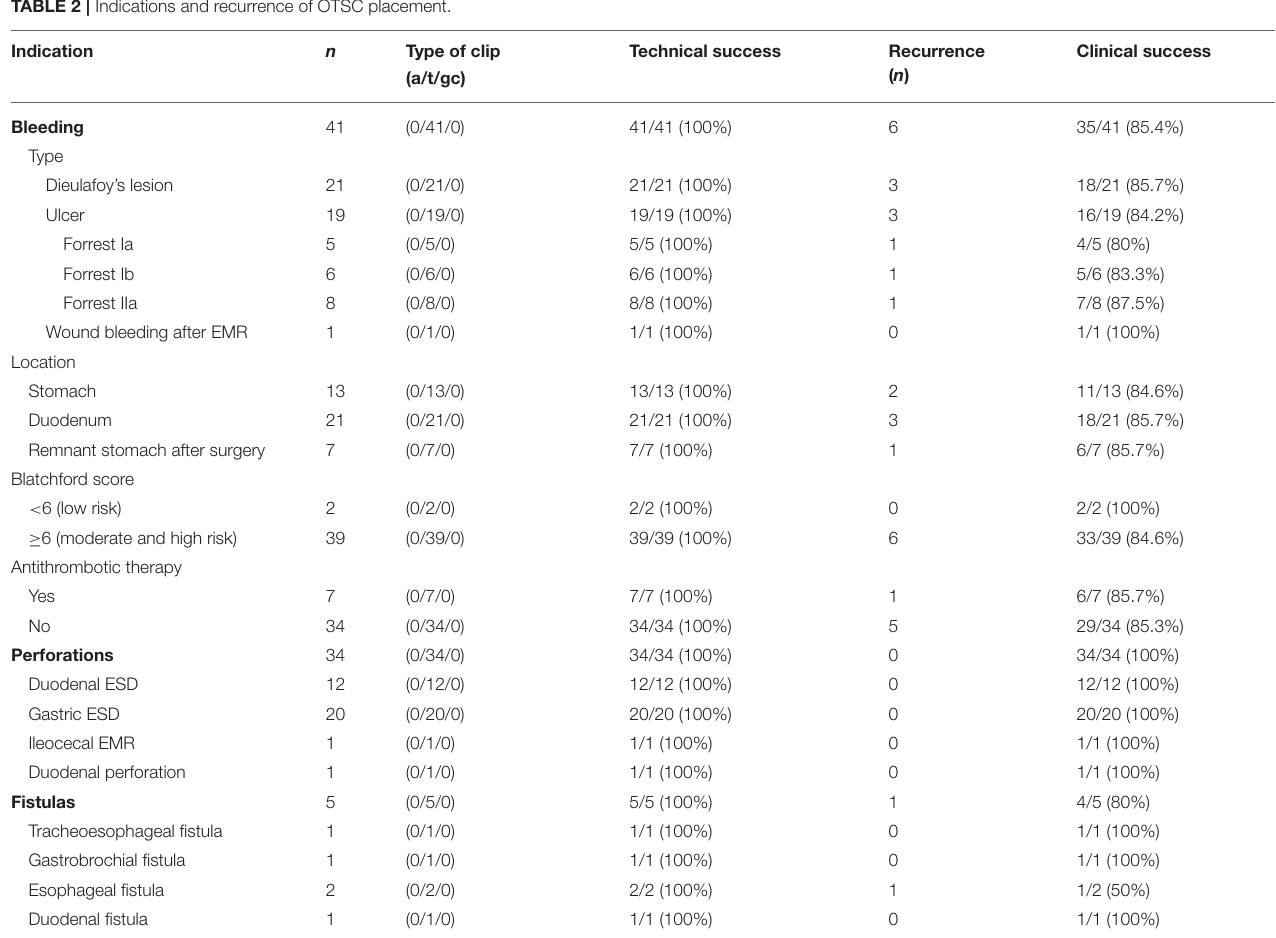
TABLE 2 | Indications and recurrence of OTSC